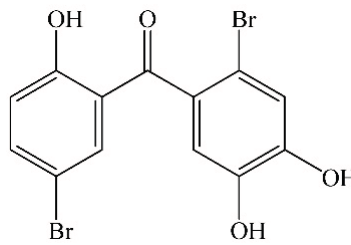
Figure 1. Chemical structure of 2,4 ′ ,5 ′ -trihydroxyl-5,2 ′ -dibromo